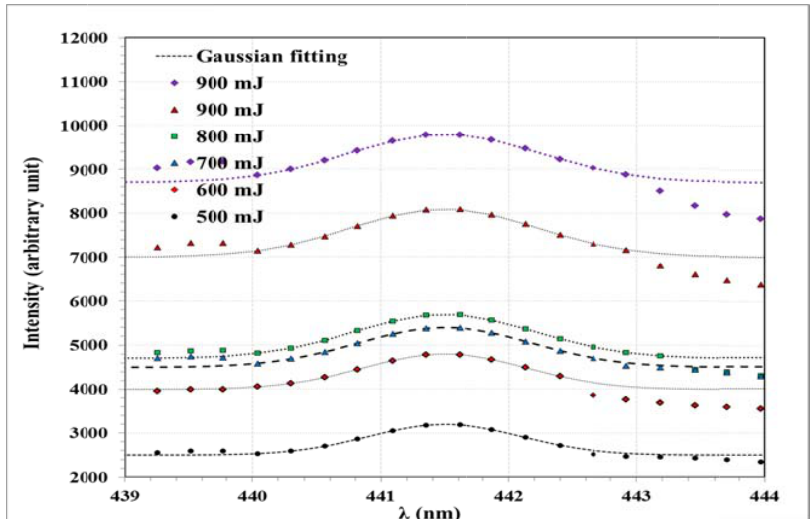
Fig. diffe Con prod with Q-sw